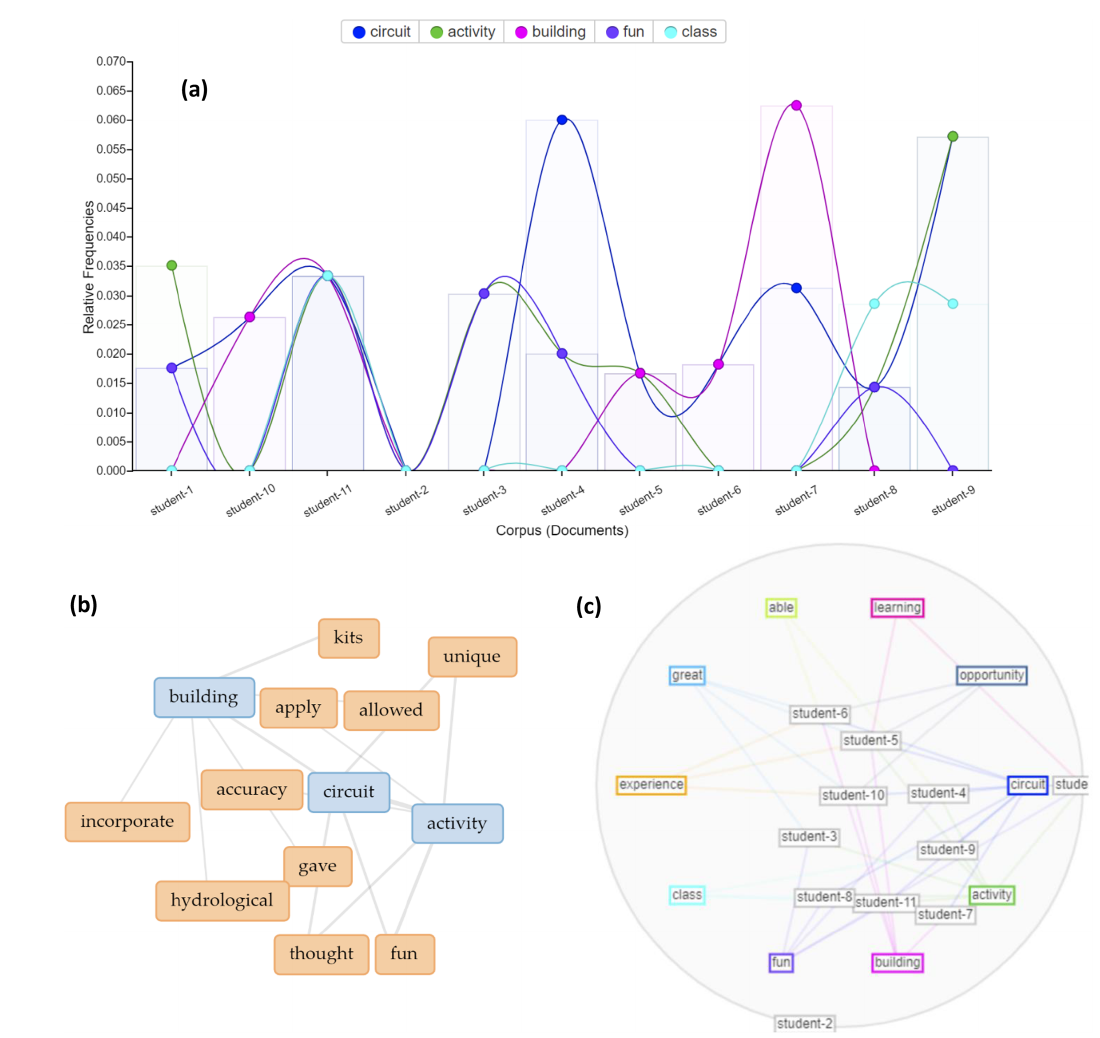
Figure 11. Text analysis for the open-ended class feedback using the Voyant software. (a) Trends plot showing words that occur most often with respect to student responses. The “Corpus” in the Voyant software refers to the student responses. (b) Links plot showing relationships between words over all responses. (c) Mandala plot indicating relationships between student responses and